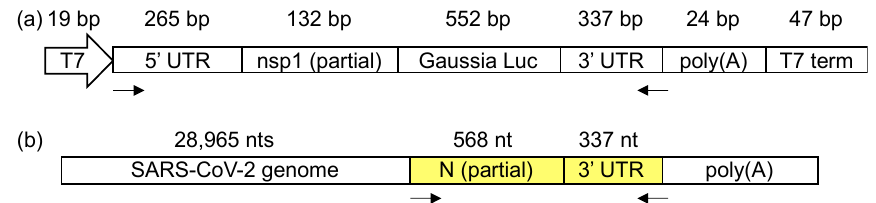
Figure 2. ( a ) The in vivo minigene, in-virion, and in vitro normalized dimethyl sulfate (DMS) activity ( Δ nDMS) profiles of the SARS-CoV-2 3 ′ UTR. Compared to the in vivo minigene, the significantly higher or lower Δ nDMS activities are labeled in red and green, respectively (> 95% confidence in Z -